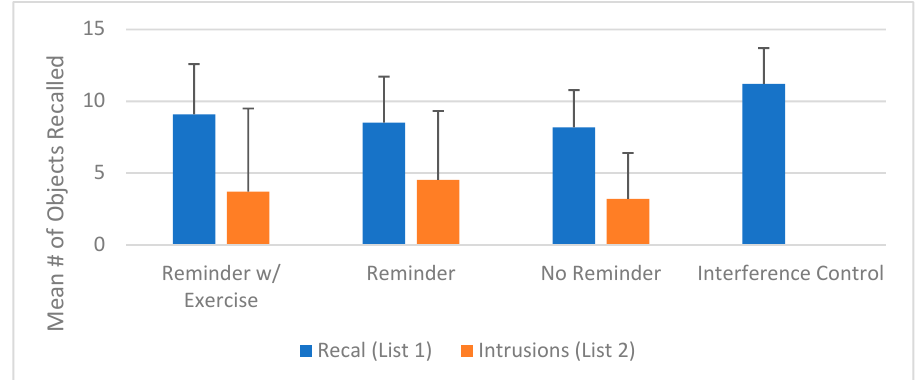
Figure 2. Mean number of objects recalled (List 1 and List 2) across the experimental conditions. Error bars represent standard deviations.